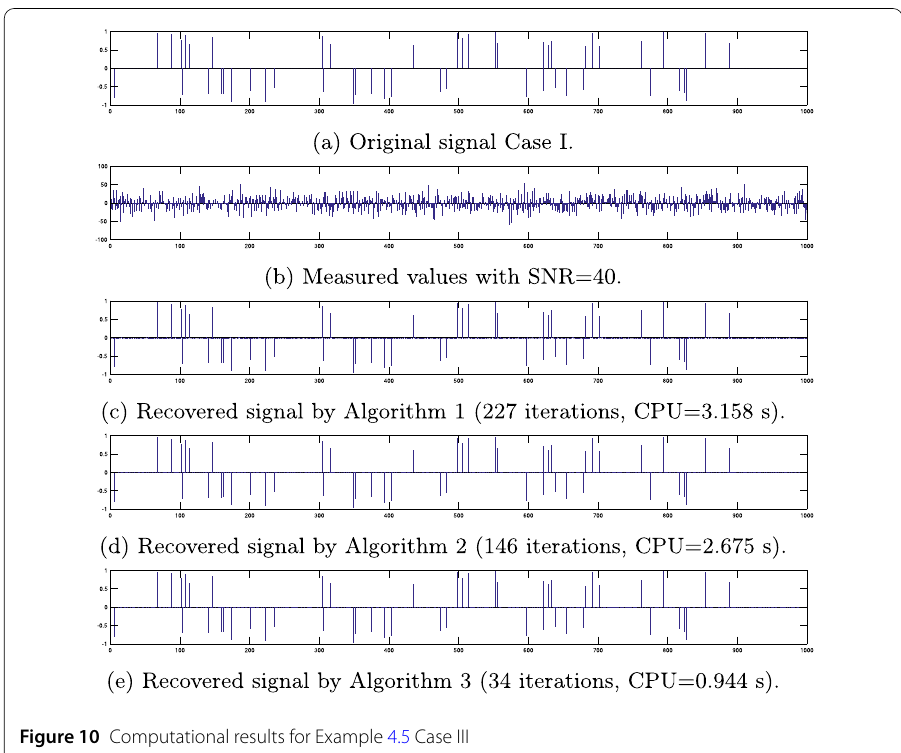
Figure 10 Computational results for Example 4.5 Case III